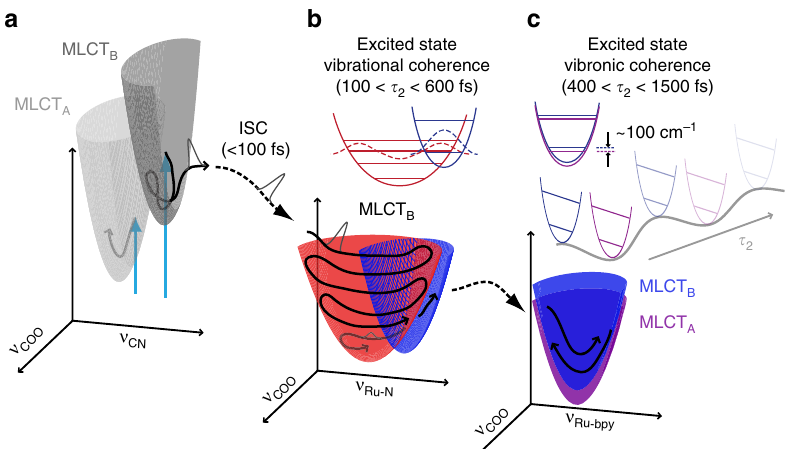
Fig. 6 Coherence evolution during the relaxation of photoexcited N3 4 − . A schematic representation of the fi rst two picoseconds of photoexcited relaxation progresses from left to right ( a – c ). Initial MLCT electronic excitation ( a ) with MLCT states coupling the donor – acceptor vibrations shown (MLCT A = light gray well; MLCT B = dark gray well) and the initial wave packet passing through ultrafast ISC. The ~600 fs propagation of the initial excited-state vibrational coherence ρ 35 ( b ) involving ν Ru-N of MLCT B (red wells); a coherence transfer to ν Ru-bpy of MLCT B (blue wells) is merely suggested with suf fi cient wavefunction overlap involving the ν Ru-bpy lowest energy vibration. The ~1 ps propagation of the excited-state vibronic coherences ρ 36 and ρ 14 involving ν Ru- − 1 nonadiabatic coupling bpy ( c ) depicts the nonadiabatic internal conversion between MLCT A (purple) and MLCT B (blue) through the 50 cm